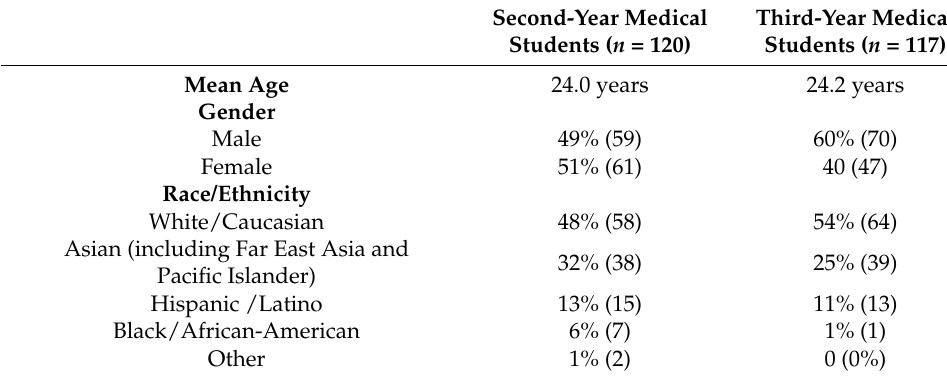
Table 1. Demographic Information of Medical School Students.